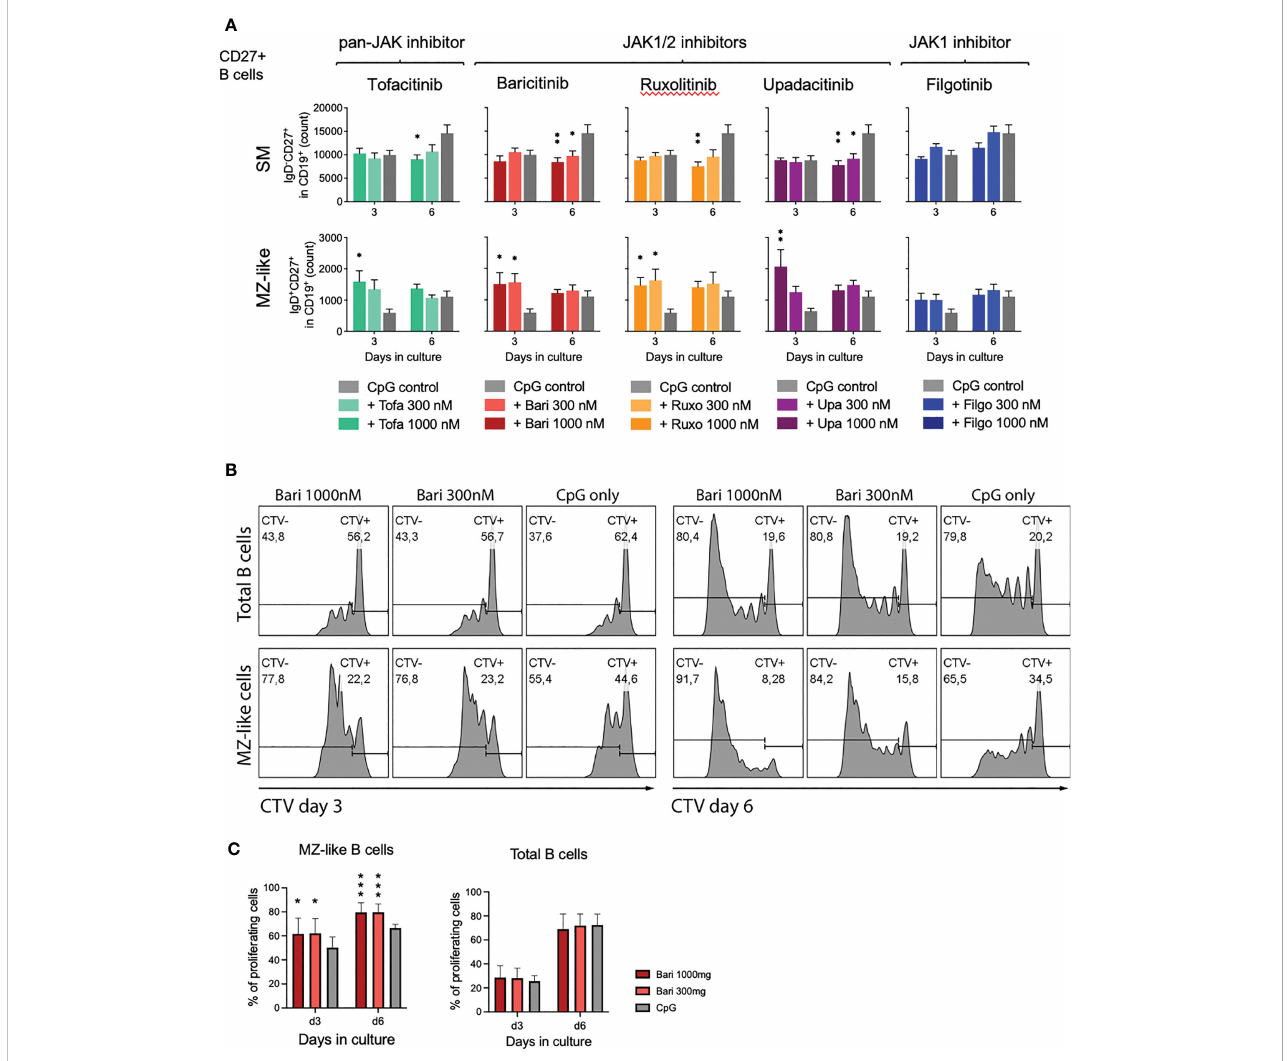
FIGURE 4 Expansion of MZ-like cells due to proliferation of pre-existing cells. (A) : Isolated CD27+ B cells were activated with CpG on day 0 and cultured in the absence or presence of indicated concentration of JAK inhibitors. On day 3 and 6, B cell subpopulations were analyzed by time acquisitioned fl ow cytometry. Data shown as mean ± SEM of 3 independent experiments, each in triplicate. ANOVA with Dunnett ’ s multiple comparisons test as follow-up test. *p < 0.05, **p < 0.005 indicate signi fi cant differences of JAK inhibitors compared to CpG control. For gating strategy and exemplary plots also see Supplementary Figure 4. (B+C): Cell Trace Violet (CTV) stained, primary total B cells were activated with CpG on day 0 and cultured in the absence or presence of indicated concentration of baricitinib. B cells were analyzed by fl ow cytometry on days 3 and 6. Exemplary plots depicted, CTV-: proliferating B cells; CTV+: non-proliferating B cells (B) . Three independent experiments, performed in triplicates, student ’ s t-test. *p < 0.05, ***p < 0.0005 indicate signi fi cant differences of JAK inhibitors compared to CpG control (C)